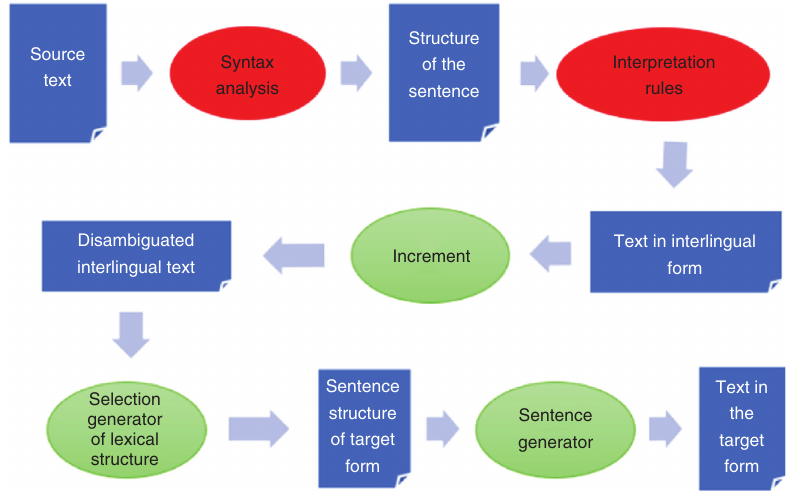
Figure 3: Knowledge-Based MT